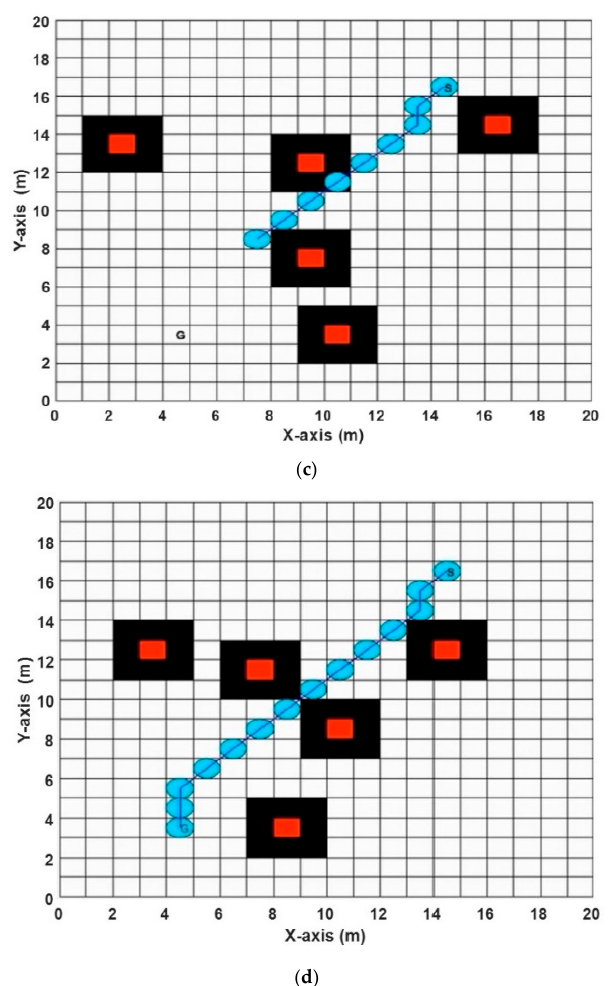
Figure 15. The best path achieved using the ABACO –based path planning algorithm in grid-based dynamic environment 2, ( a ) the mobile robot starts from its starting position, ( b ) the mobile robot is moving toward its goal position, ( c ) the mobile robot is at its midway and is avoiding the obstacles, ( d ) the mobile robot is approaching its goal